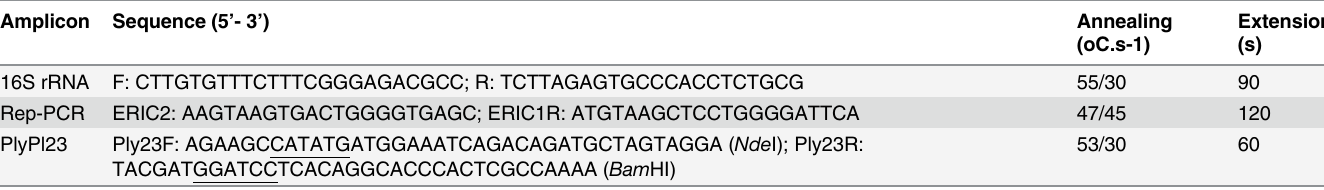
Table 1. Primers and PCR conditions used for P . larvae 16S-PCR identification, rep-PCR analysis and PlyPl23 cloning. Amplicon Sequence (5 ’ - 3 ’